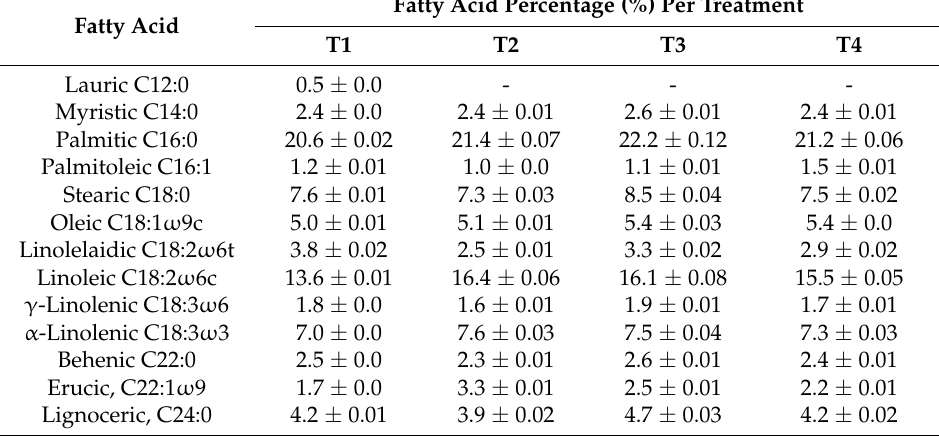
Table 4. Fatty acid profiles presented in arnica supercritical extracts. Results are presented in percentage ( w / w% ).